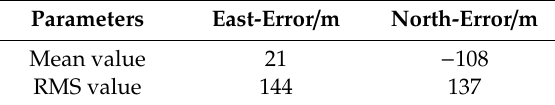
Table 2. Error statistic results of positioning with the ring alert signal and height aiding in weak signal environment.